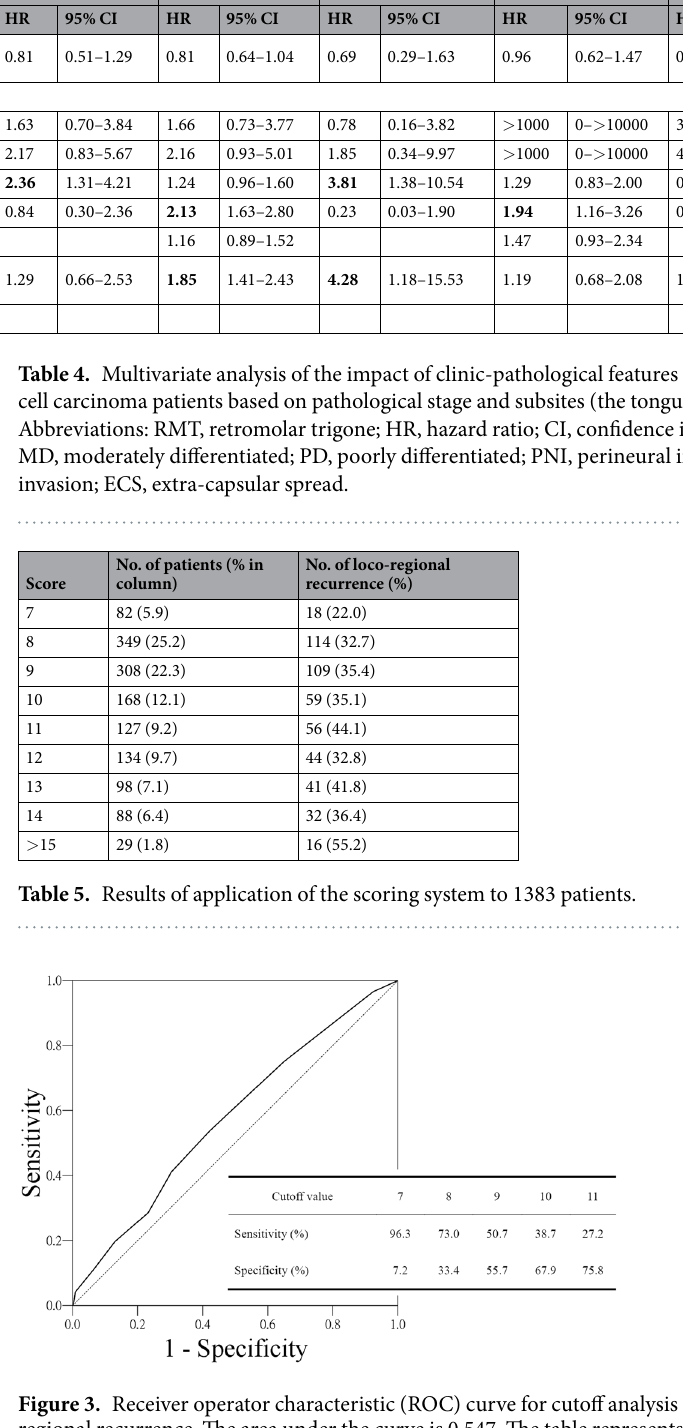
Figure 3. Receiver operator characteristic (ROC) curve for cutoff analysis of score in patients with loco- regional recurrence. The area under the curve is 0.547. The table represents statistical parameters calculated for different cutoff values to predict loco-regional